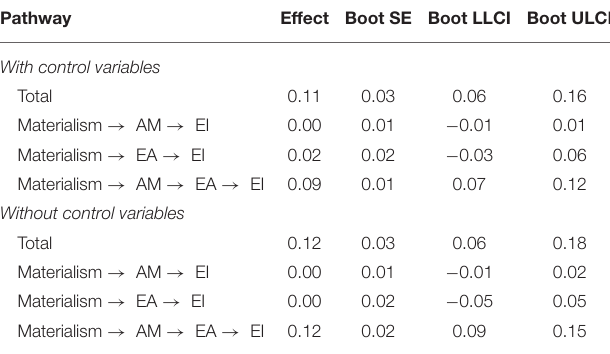
TABLE 5 | Indirect effects of materialism on entrepreneurial intention.